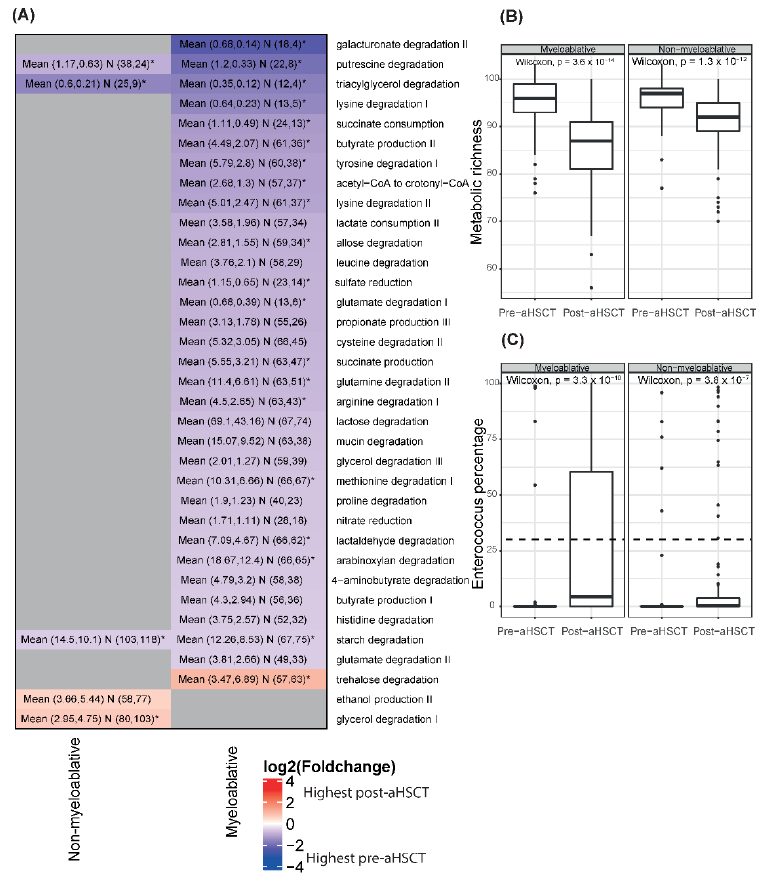
Figure 6. Associations of GMMs and Enterococcus profiles with timepoints . ( A ) Heatmap on GMM level of the log2 fold changes between the pre-aHSCT and post-aHSCT sampling period stratified by conditioning regimen. The plot shows all GMMs that are significantly different in at least one comparison based on a Wilcoxon test. Gray means not significant. Blue colors show that the mean abundance of a GMM is higher in the pre-aHSCT period than in the post-aHSCT period and red shows the opposite direction. The text in the cells shows “Mean (mean (pre-aHSCT), mean (post-aHSCT)) N (number of pre samples with the GMM present, number of post samples with the GMM present). A star indicates that the comparison is also significant in the paired analysis”. The total numbers of samples are pre-aHSCT myeloablative = 67, pre-aHSCT non-myeloablative = 104, post-aHSCT myeloablative = 76, post-aHSCT non-myeloablative = 116. ( B ) Boxplots of metabolic richness in pre- aHSCT vs. post-aHSCT samples for myeloablative patients and non-myeloablative patients. Wilcoxon tests were performed per conditioning regimen. ( C ) Boxplots of the percentage of Enterococcus in pre-aHSCT vs. post-aHSCT samples for patients undergoing myeloablative and non-myeloablative conditioning. Wilcoxon tests were performed per conditioning regimen. The dotted lines indicate the threshold for domination by Enterococcus